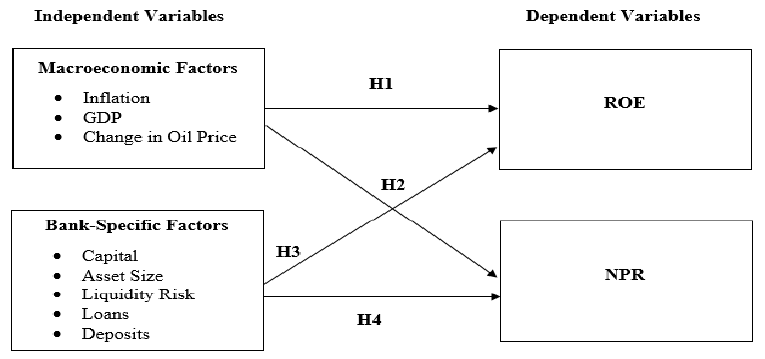
Figure 1: Conceptual Framework of the